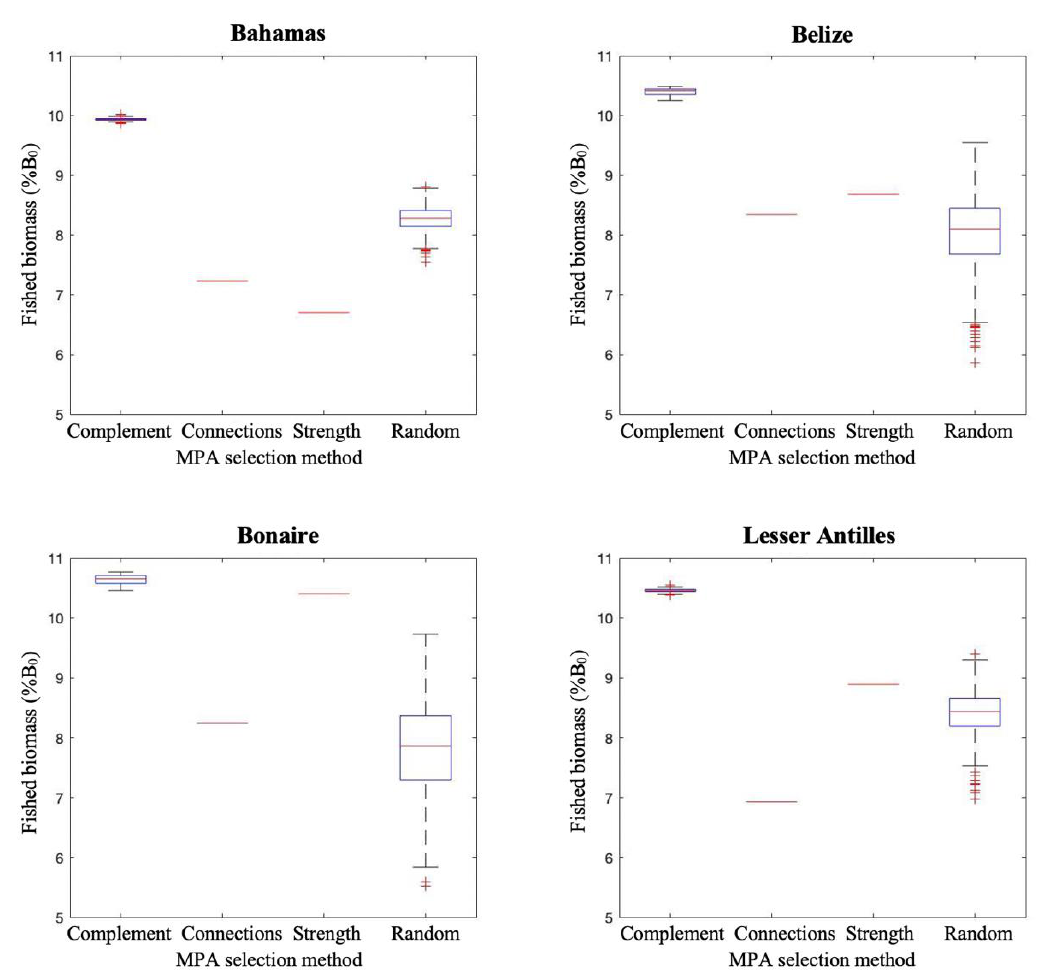
Figure 5. Equilibrium fish biomass in fished areas (unprotected areas) predicted for different MPA selection strategies, at 20% MPA coverage. Simulated biomass is represented as a percentage of the total unfished biomass (B 0 ). Complement refers to the proposed algorithm, selecting MPA systems that minimise larval export redundancy ( n = 1000). Scenarios “Connections” and “Strength” refer to the selections based on fixed metrics of larval export connection numbers and export strength, respectively ( n = 1). Random represents haphazard protected area placement that still achieved the same habitat coverage as targeted placement strategies ( n = 1000).